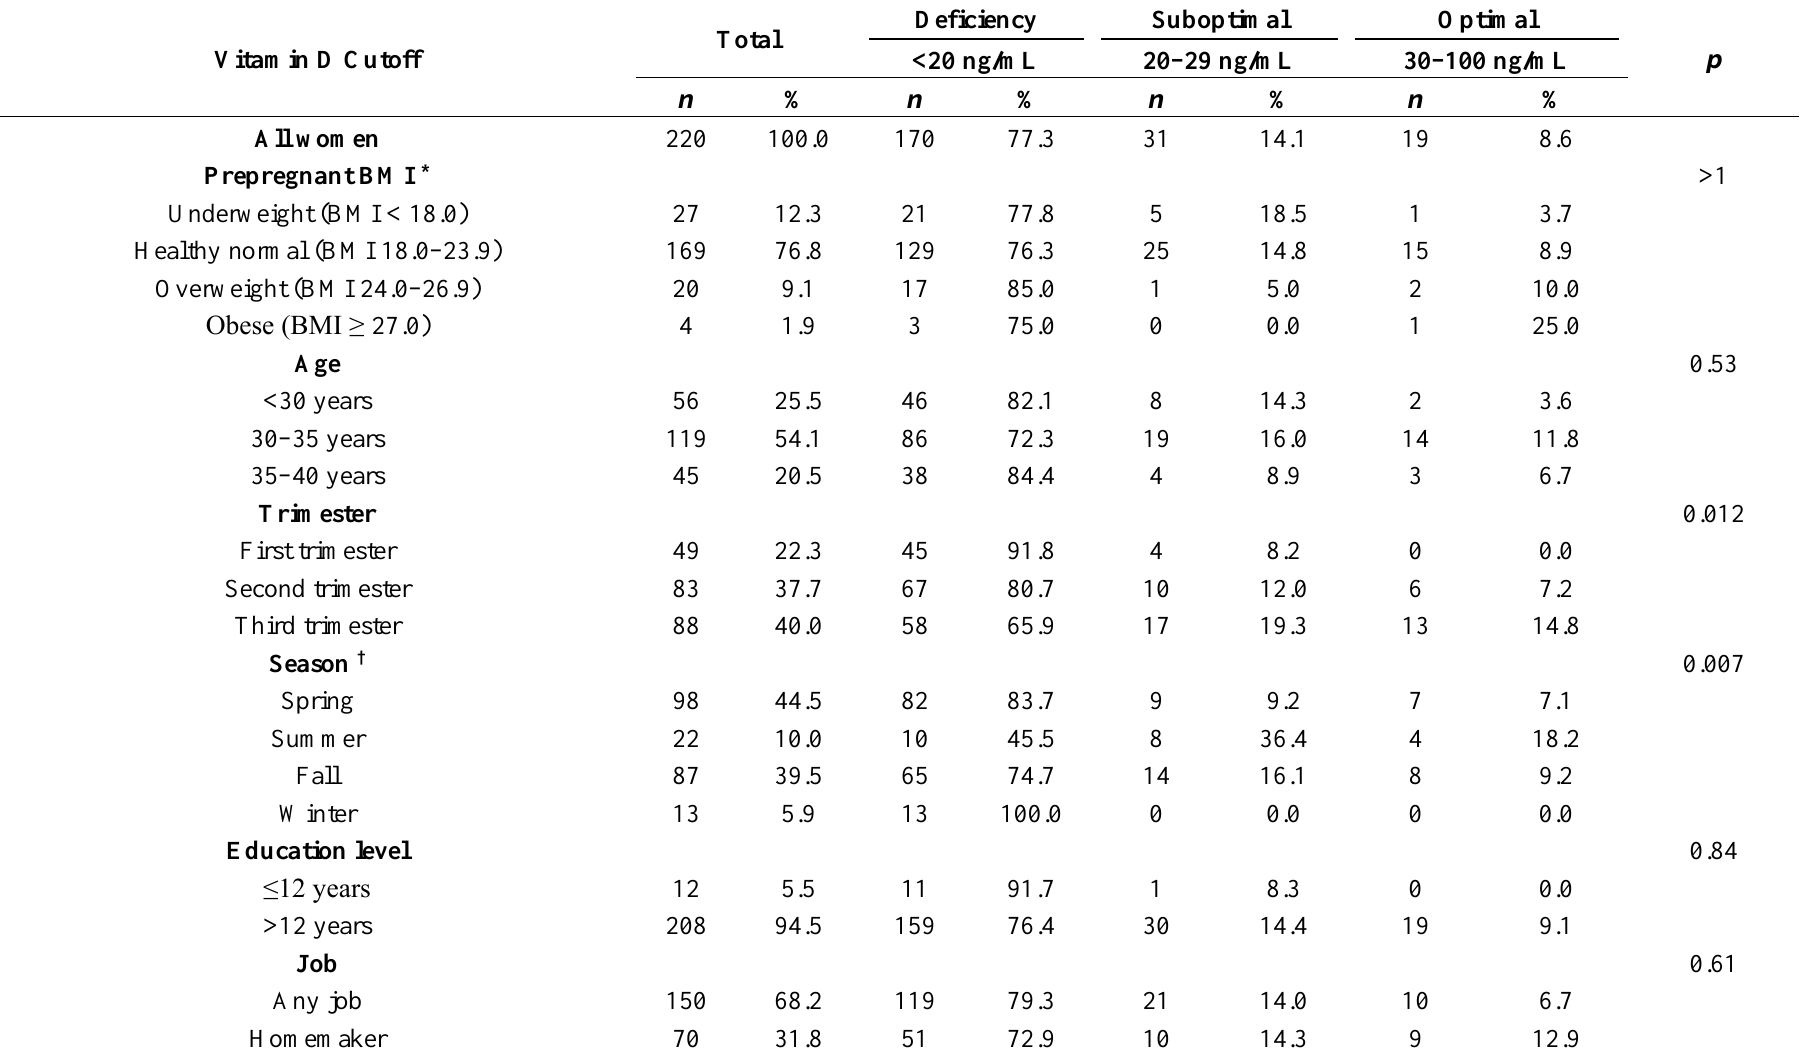
Table 3. Maternal characteristics and vitamin D status of 220 pregnant Korean